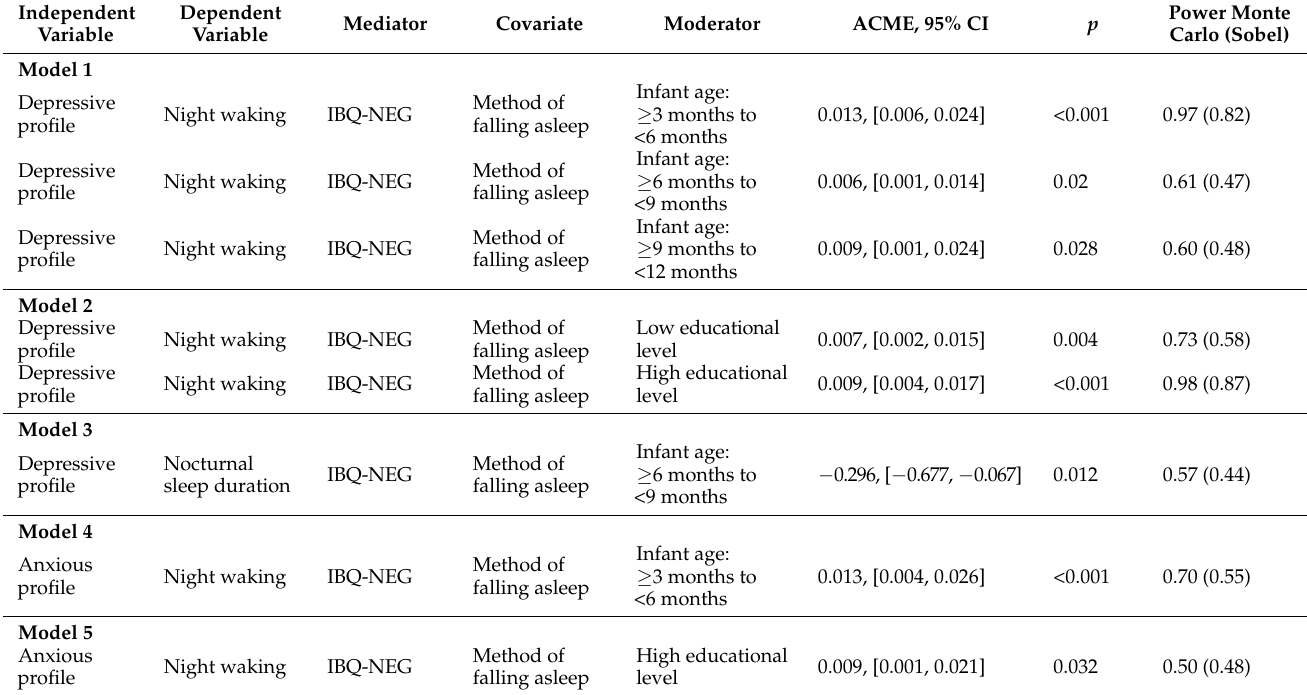
Table 4. Significant moderated mediation models investigating relationships between maternal mental health symptom profiles and infant